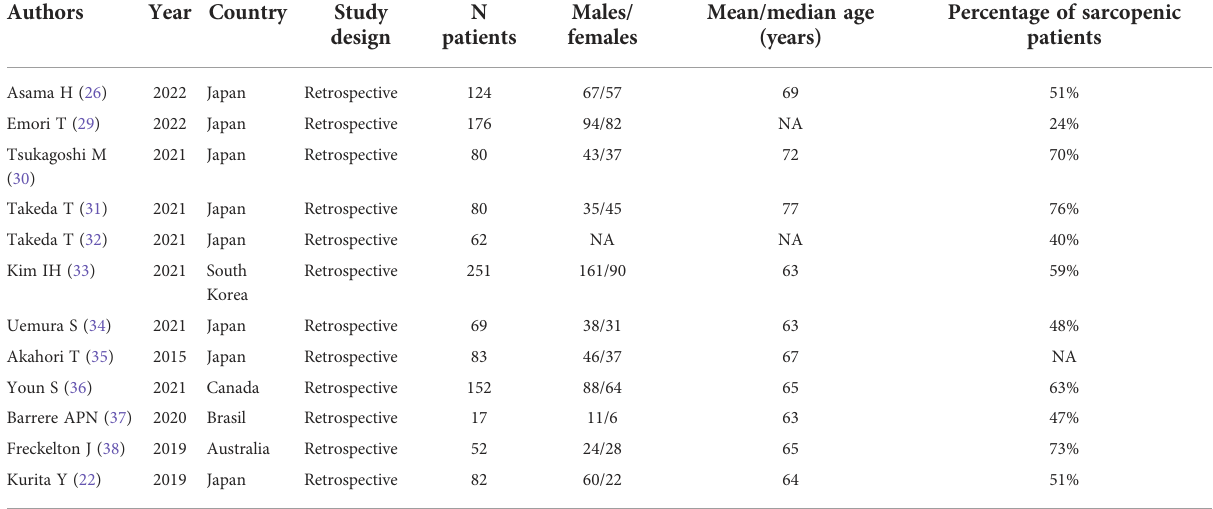
TABLE 1 Basic study and population